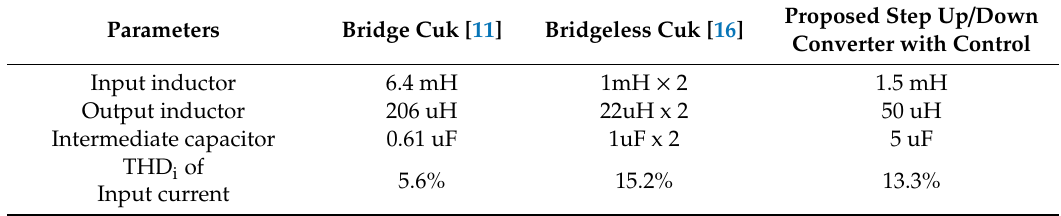
Class D standard. Table 3. Comparisons of the total harmonic distortion of the step up / down